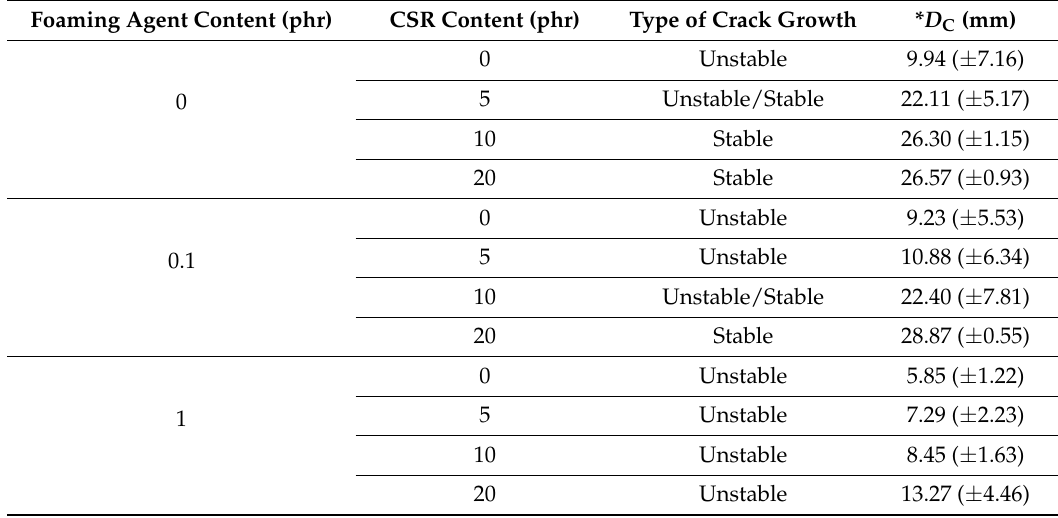
* D C = Displacement for